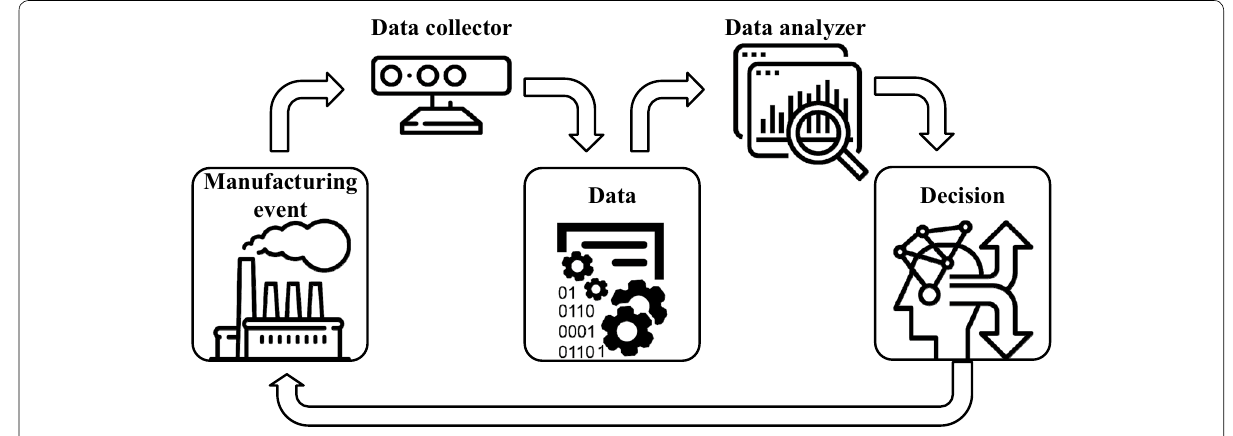
Figure 1 Closing the loop of data-driven